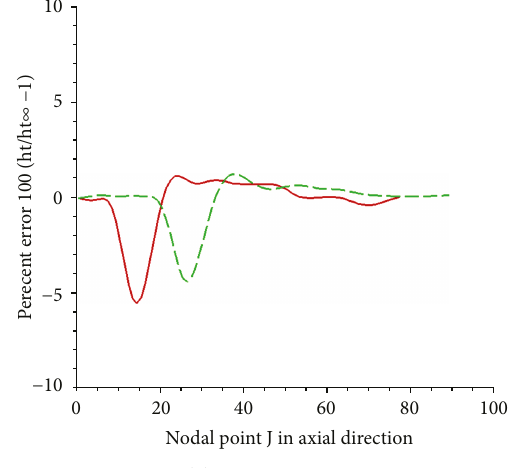
Figure 13: L2-residual convergence history of the solid Gasjet